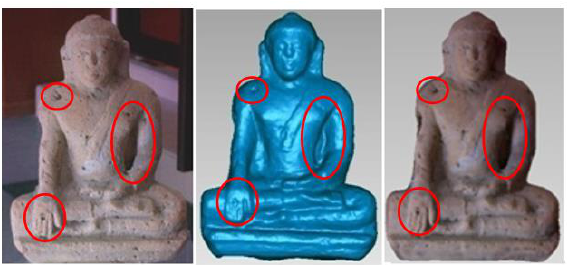
Figure 16. Comparison of the level of detail for terracotta Buddha statuette; real image (left), point clouds model (middle) and photorealistic 3D model (right)